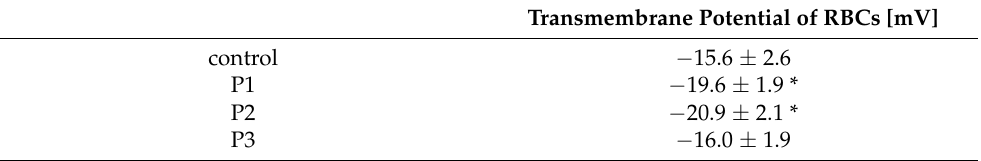
Table 2. Transmembrane potential ± SD of control RBCs and RBCs modified by P1, P2 and P3 liposomal formulation in in vitro studies. * Statistically significant differences between control and P1, P2 or P3-treated cells are denoted ( α =